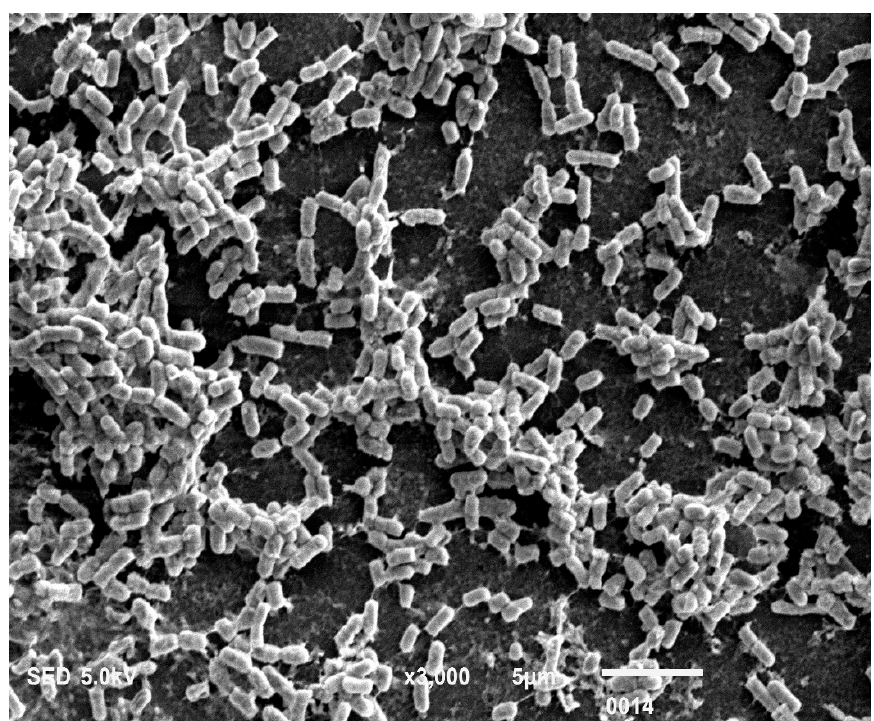
Figure 7. Free-floating multicellular aggregates or clumps of cells collected from broth tube. The clumps or multicellular aggregates formed in broth, especially at the air-water interface after 48 h of incubation. These floating multicellular aggregates do not adhere to any surface and the majority of the cells are devoid of nanotube structure.